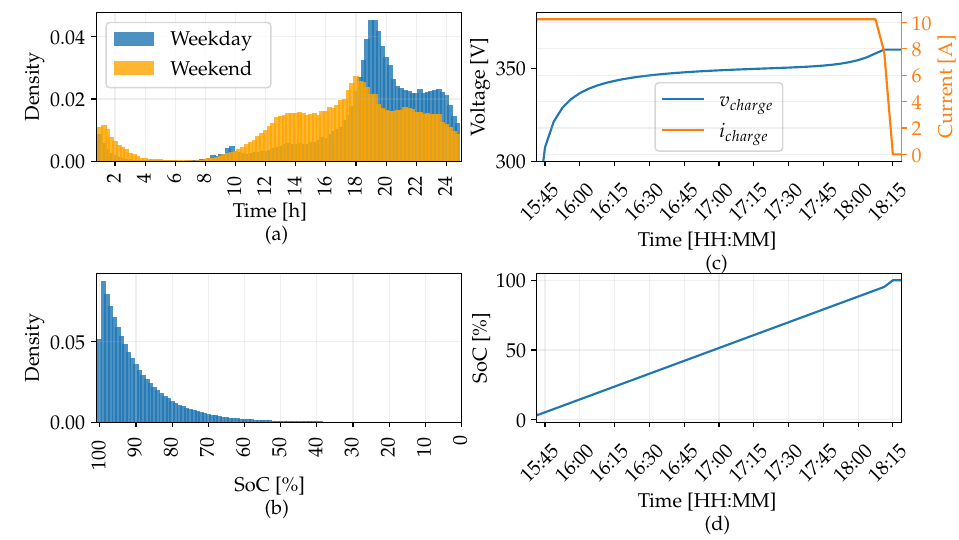
Figure 2. Probability densities and dynamic charging curves, with: ( a ) the distribution of arrival times for weekdays and weekends; ( b ) the SoC upon arrival at destination. Both right panels are representative of a randomly selected day with: ( c ) the charging voltage and current; ( d ) the respective SoC curve.